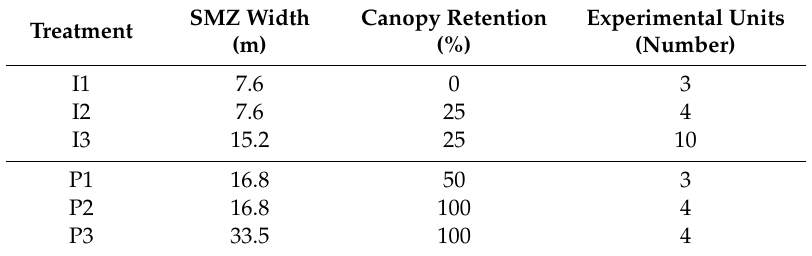
Table 1. Streamside management zone (SMZ) treatment variants by stream type, including SMZ width, percent canopy retention and the number of fixed area experimental units established to correlate sediment path occurrence with equipment operation intensity and sediment path